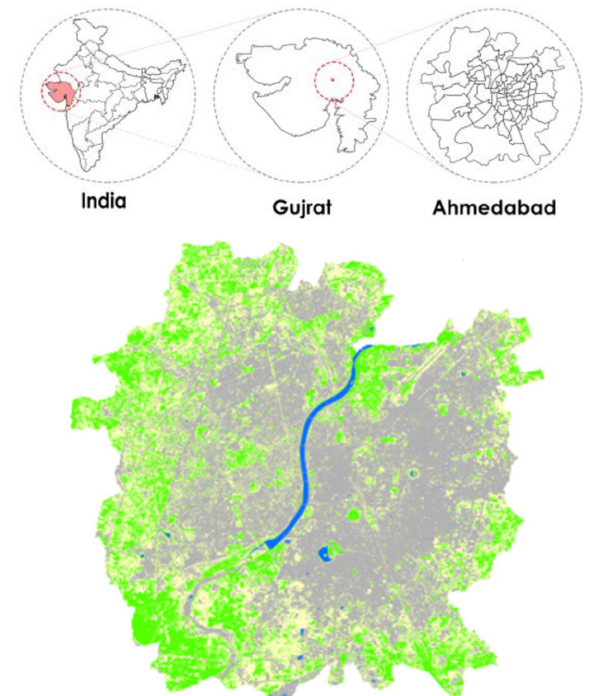
Figure 2. Distribution of green areas across the city of Ahmedabad, 2017. The green, blue, and grey areas indicate vegetation, water bodies, and urban sprawl, respectively. Source: [54].